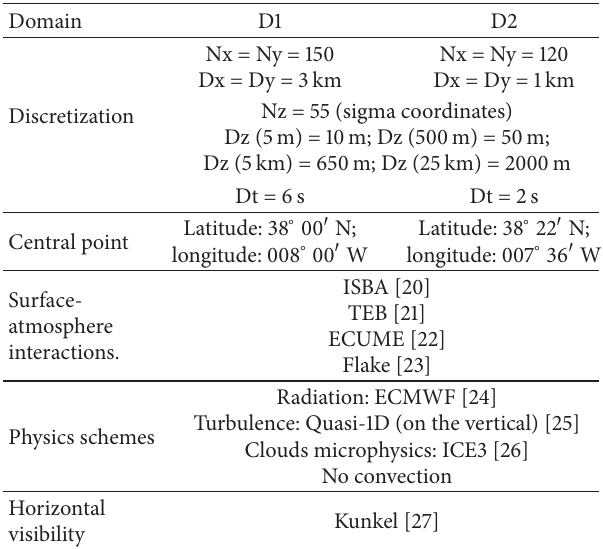
Table 2: Adopted features for the final Meso-NH